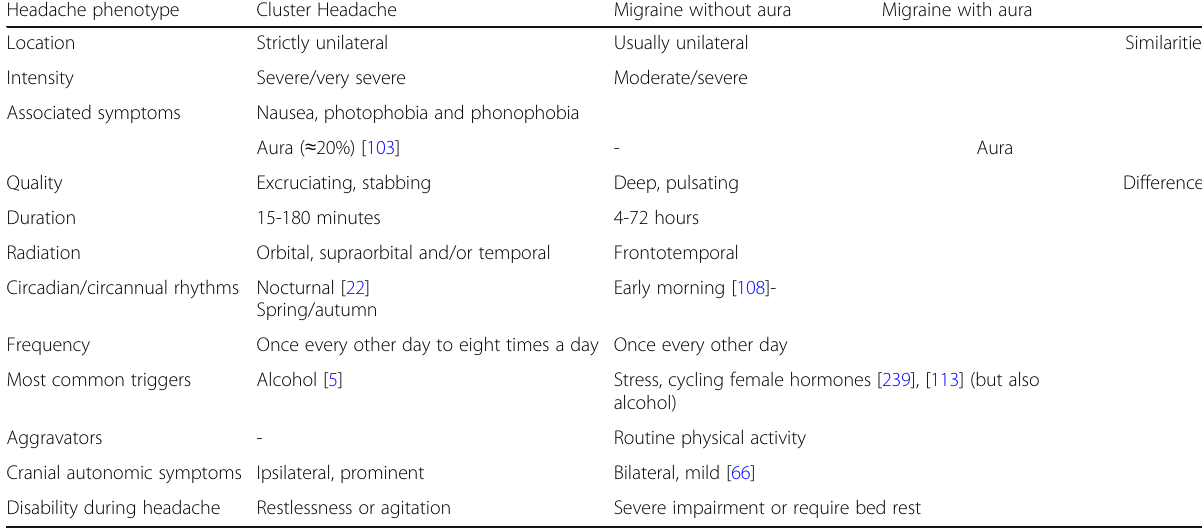
Table 3 Clinical similarities and differences amongst cluster headache, migraine without aura and migraine with